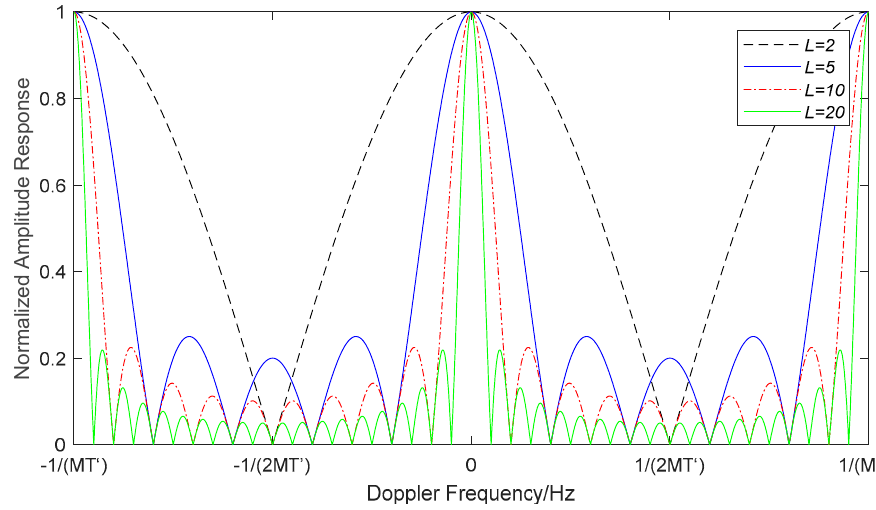
Figure 7. Normalized amplitude response of block accumulation.